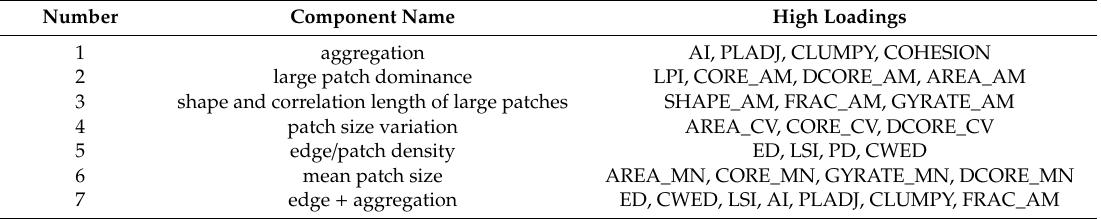
Table 5. Class-level configuration components of landscape